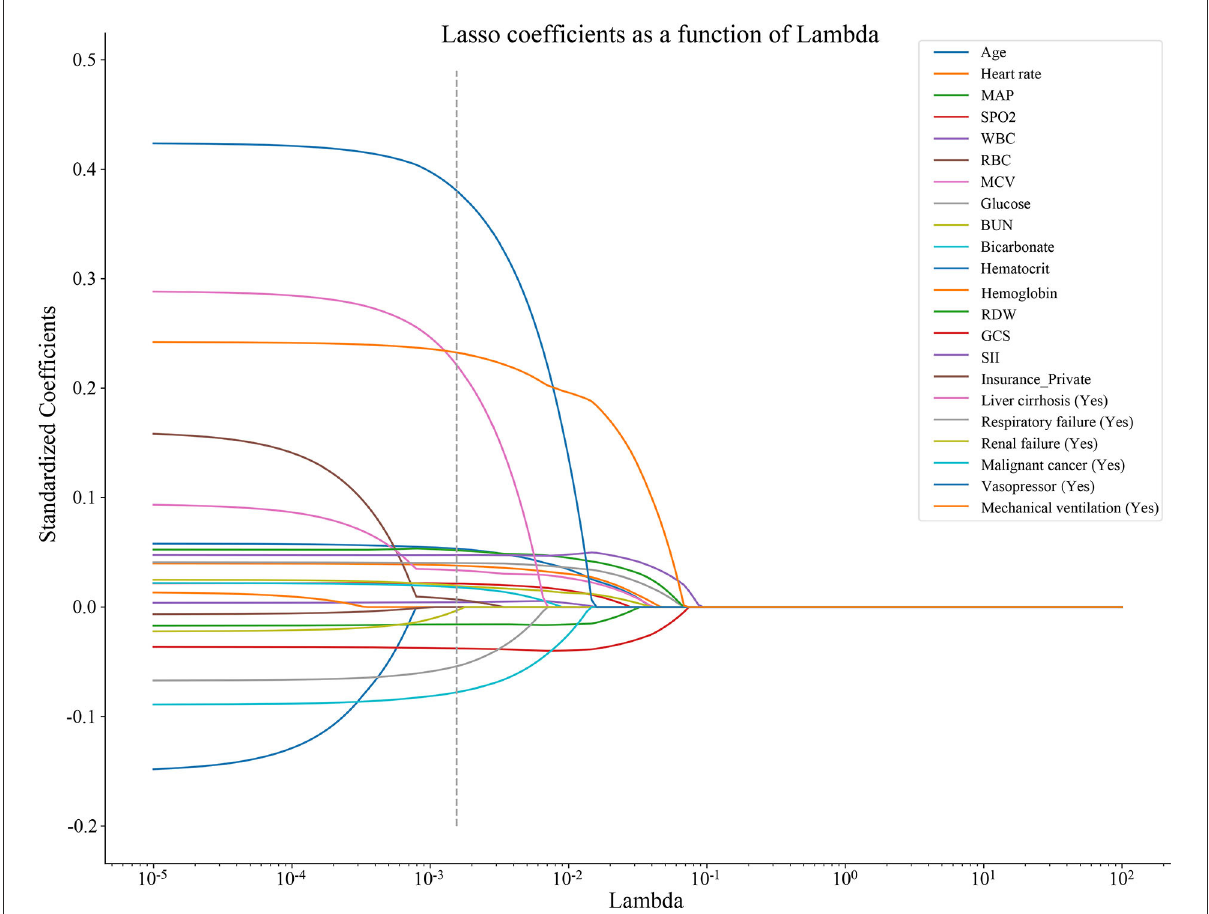
FIGURE2 The predictors were selected in the LASSO regression analysis by the 10-fold cross-validation, and the optimal penalty parameter was 0.00155. LASSO, least absolute shrinkage and selection operator; MAP, mean artery pressure; SpO2, oxygen saturation; WBC, white blood cell count; RBC, red blood cell; MCV, mean corpuscular volume; BUN, blood urea nitrogen; RDW, red blood cell distribution width; GCS, Glasgow Coma Scale; and SII, systemic immune-inflammation.